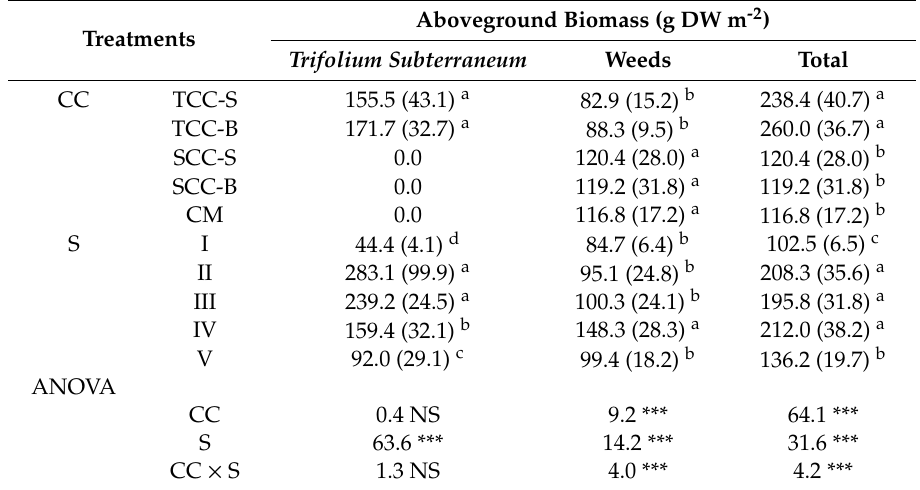
Values are means with standard deviation (in brackets). Values within a column followed by di ff erent letters are significant at p ≤ 0.05 (Tukey’s HSD test). TCC-S: Trifolium subterraneum cover cropping leaving dead mulch on the